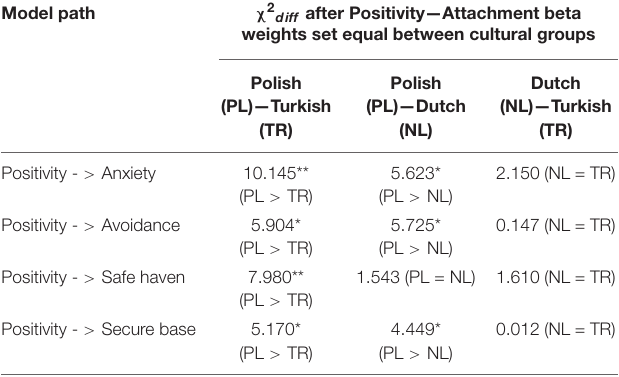
TABLE 3 | Chi square differences ( χ 2 diff ) between: (1) a model with free estimated paths versus (2) a model with two compared paths set equal (positivity-attachment versus negativity-attachment anxiety-negativity/positivity versus avoidance-negativity/positivity; and safe haven-negativity/positivity versus secure base-negativity/positivity) in cultural groups and in the total sample. Model